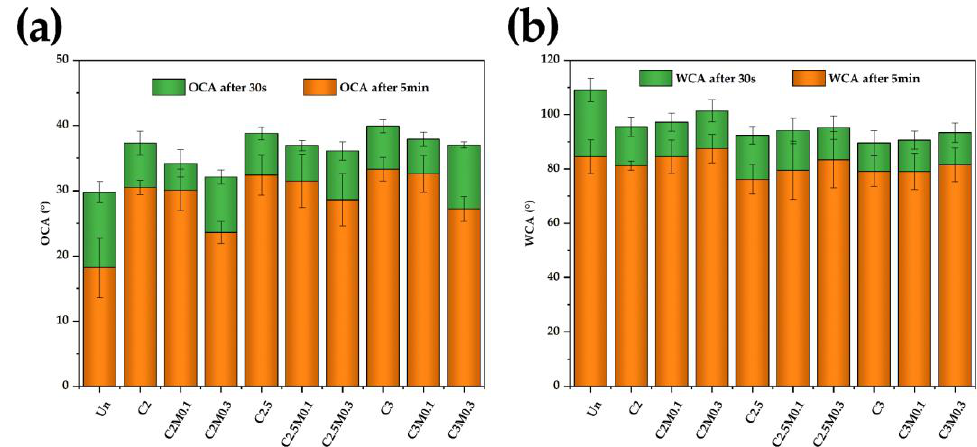
Figure 4. CAs of the uncoated and coated papers to ( a ) castor oil and ( b )